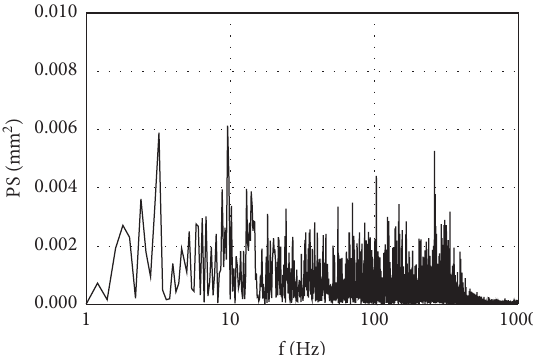
Figure 9: Power spectrum of shock oscillations for microstep at X / C � 0.02.